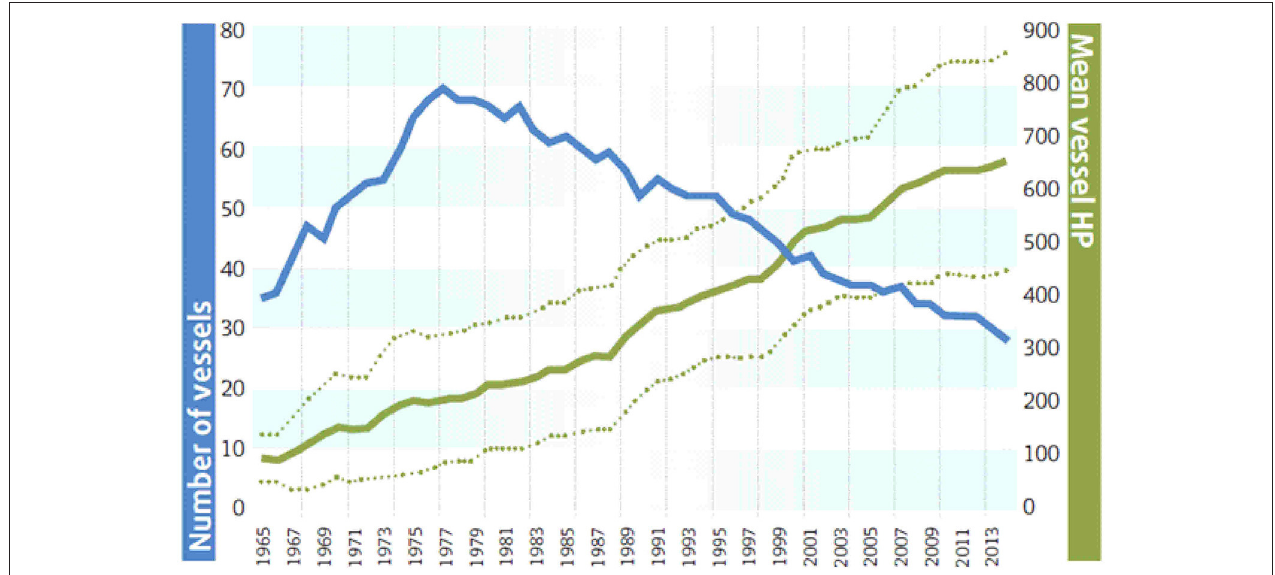
FIGURE 1 | Number of vessels along with its mean and standard deviation of gear power (HP) of the bottom trawl fleet from Mallorca (Balearic Islands) during